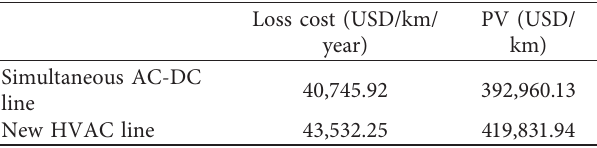
Table 7: Annual loss